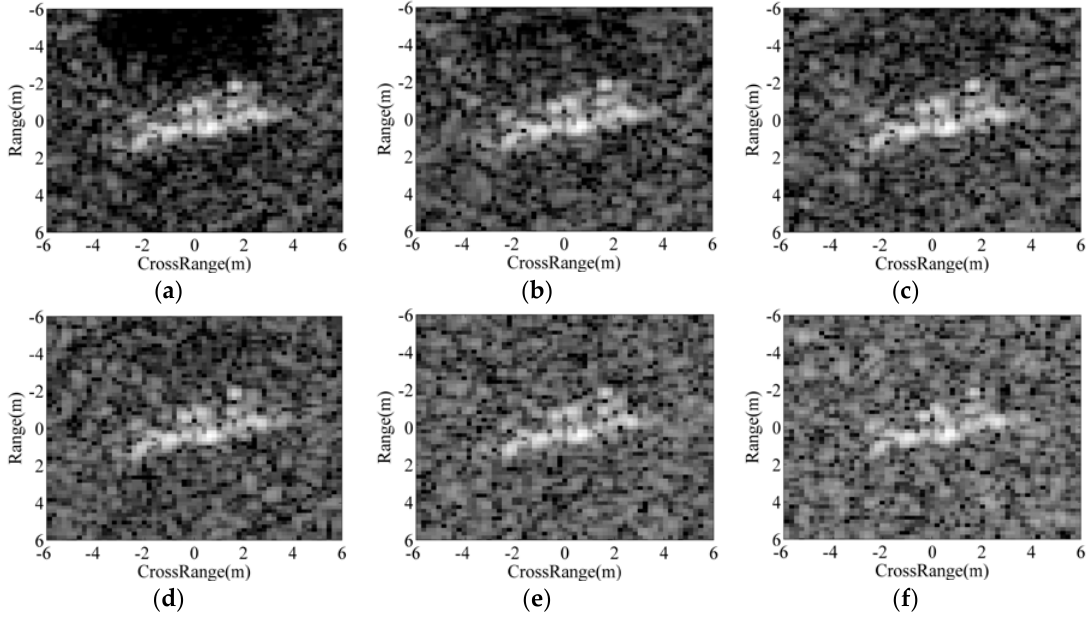
Figure 10. Noisy images with different levels of additive white Gaussian noises (AWGN) addition.